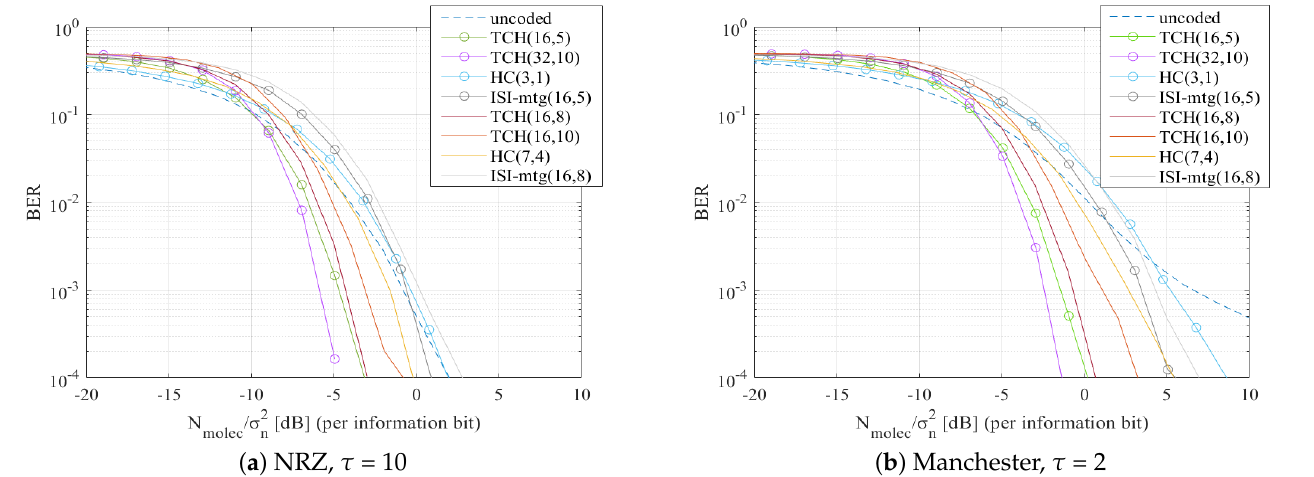
Figure 8. BER comparison for all the considered channel codes, using OOK